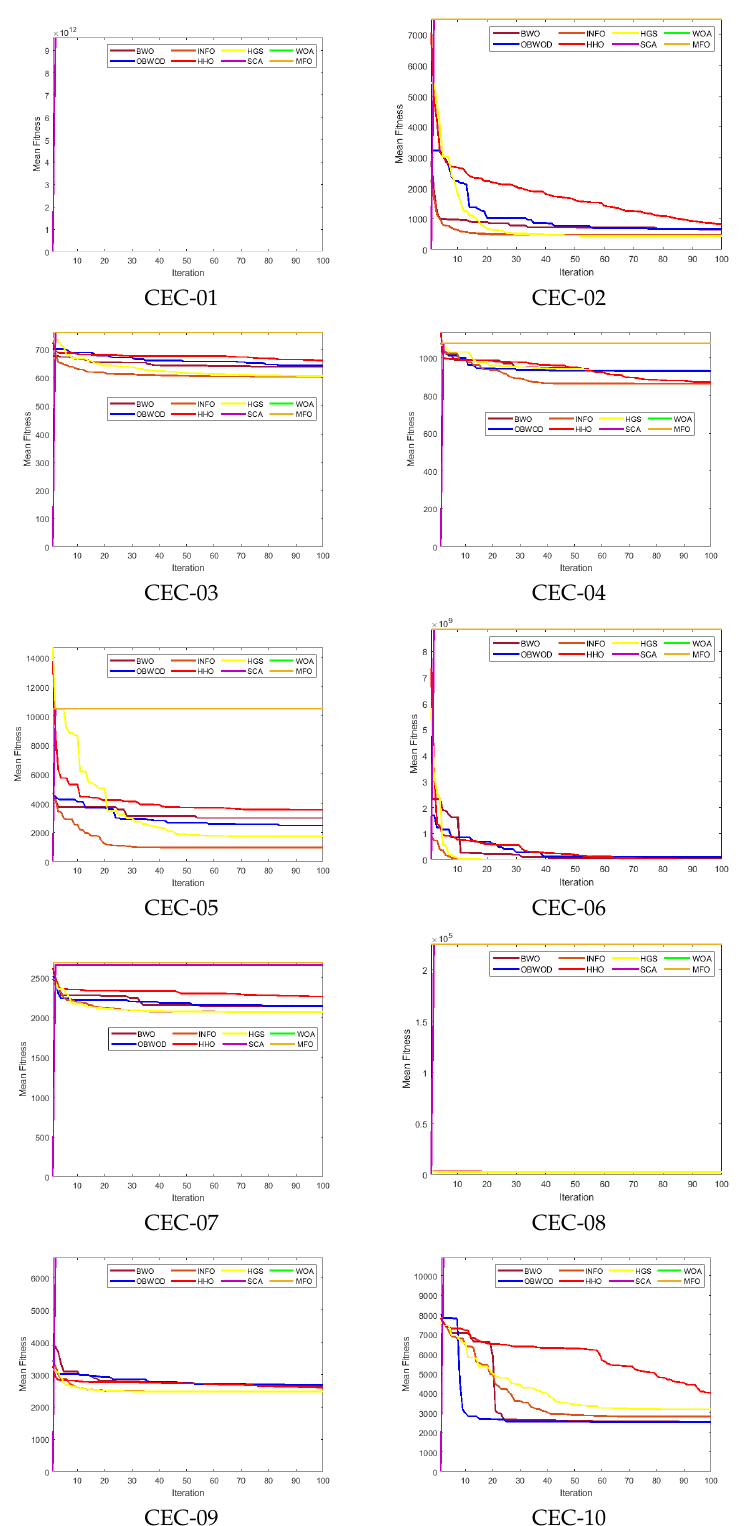
Figure 3. Convergence curves of the proposed OBWOD and the compared optimization algorithms obtained on CEC’22 test